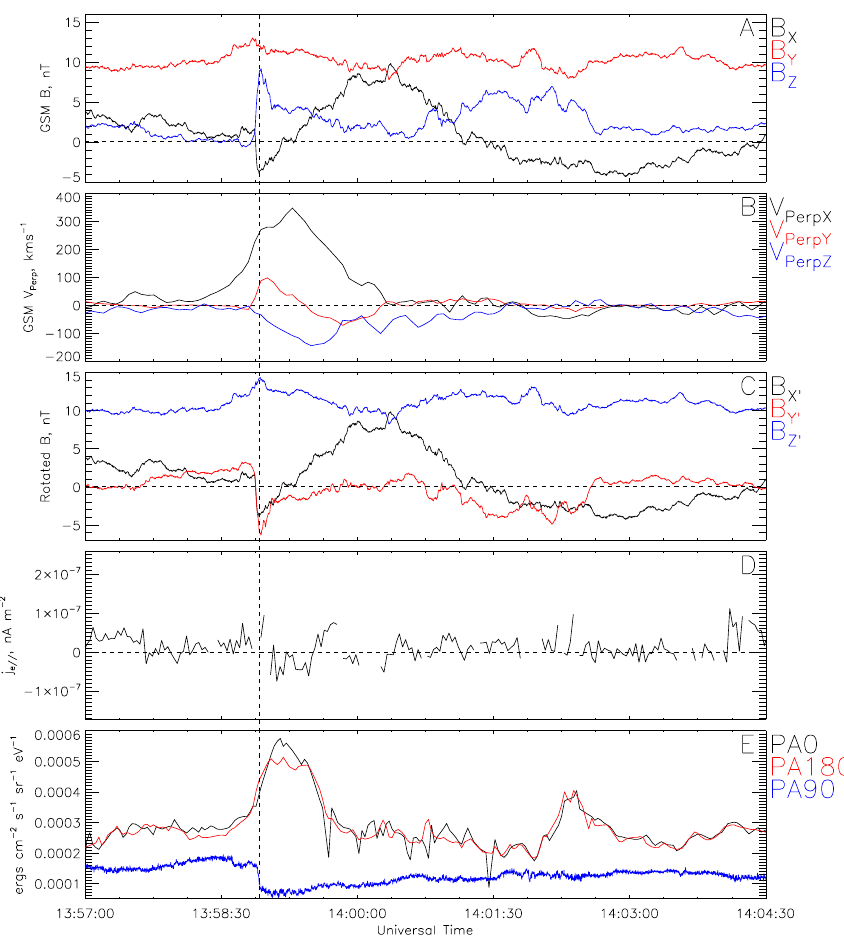
Fig. 10. Data pertaining to the entry of C1 into the plasma bubble. Panel (A) shows GSM components and magnitude of magnetic field, panel (B) the GSM components of V ⊥ , panel (C) the magnetic field rotated about GSM X into a coordinate frame that eliminates any Y component in the undisturbed magnetic field, in order to identify any draping in the field around the plasma bubble. Panel (D) is the parallel electron current calculated from 2-D pitch angle distributions in the energy range covered by both PEACE sensors. Panel (E) shows the electron differential energy fluxes separately for 0 ◦ PA (pitch angle), 180 ◦ PA and 90 ◦ PA, taken from 3-D distributions returned by both the HEEA and LEEA sensors and summed over their common energy range. The vertical dashed line marks the entry of the spacecraft into the plasma